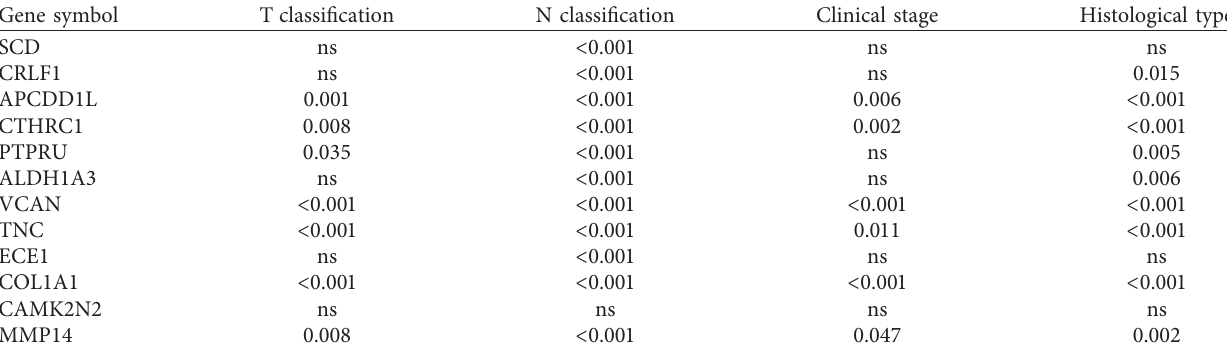
Table 4: The association between potential target genes and clinicopathological features of PTC. Gene